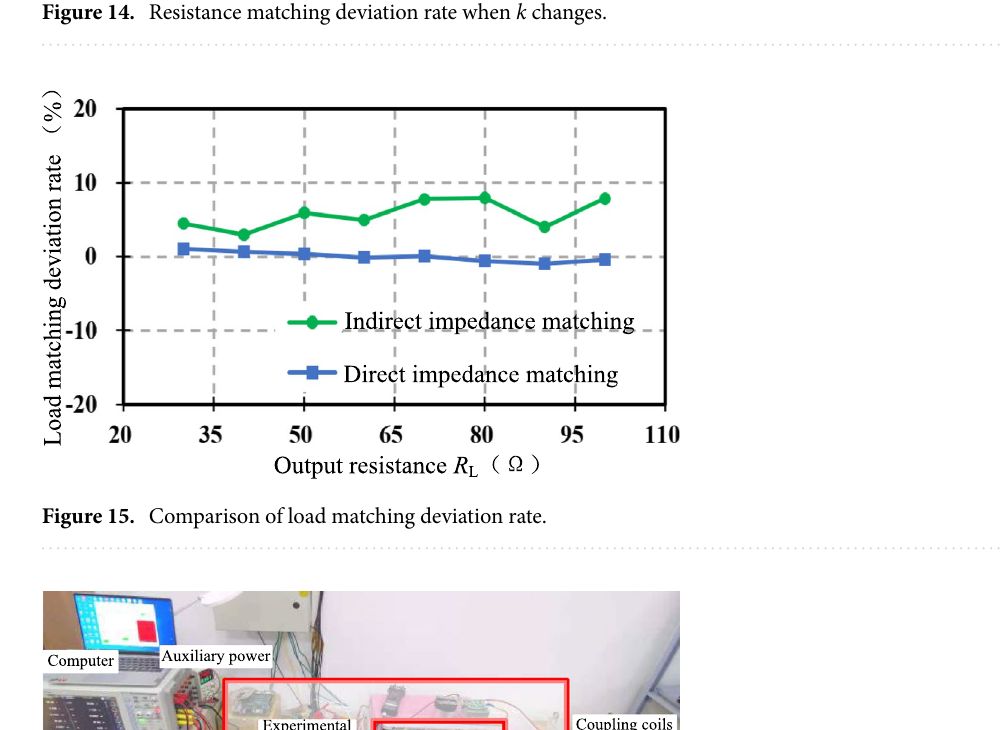
Figure 14. Resistance matching deviation rate when k changes.